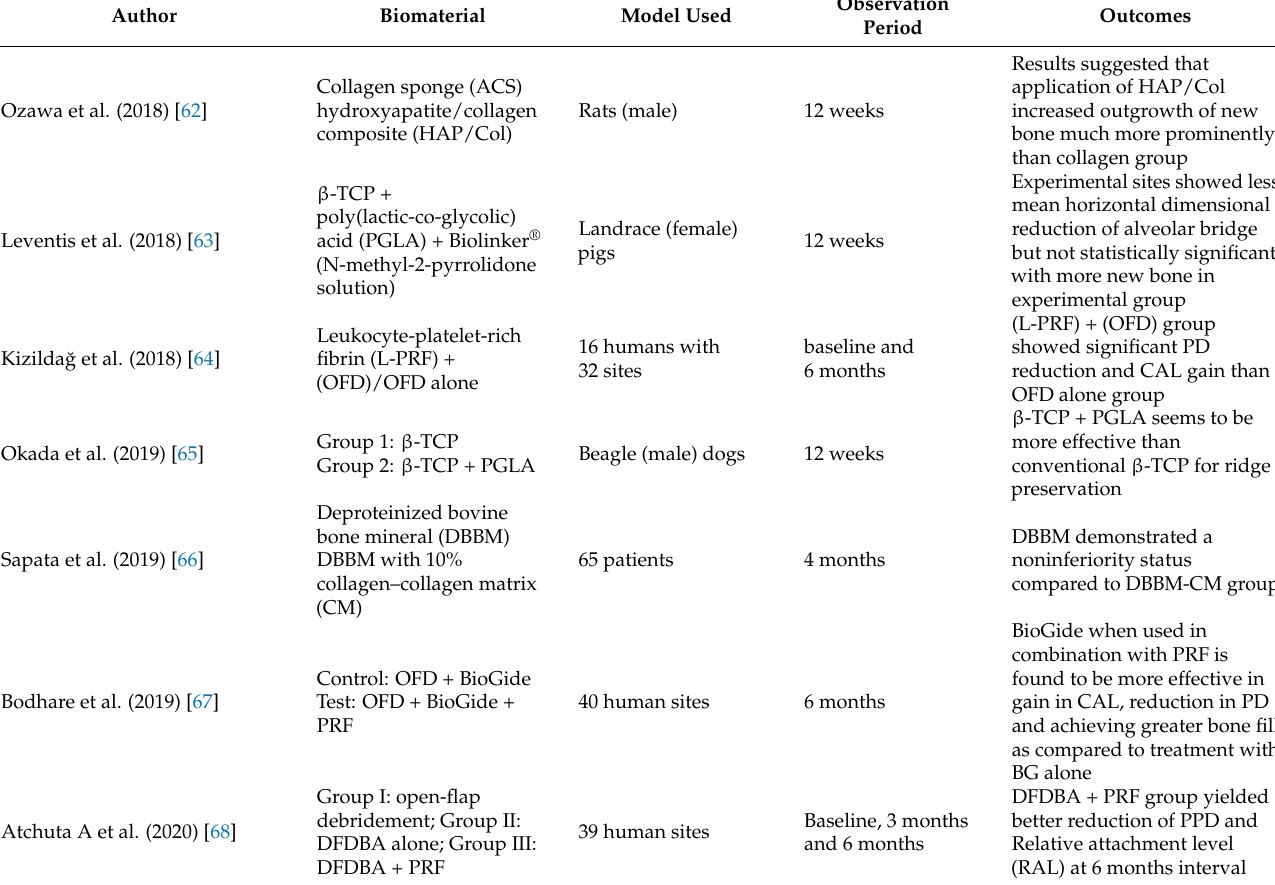
Table 1. Detailed summary of the application of bone grafts with/without